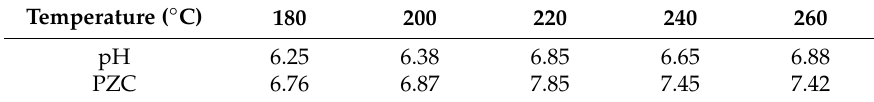
Table 4. E ff ect of temperatures on surface pH and points of zero charge (PZC) of